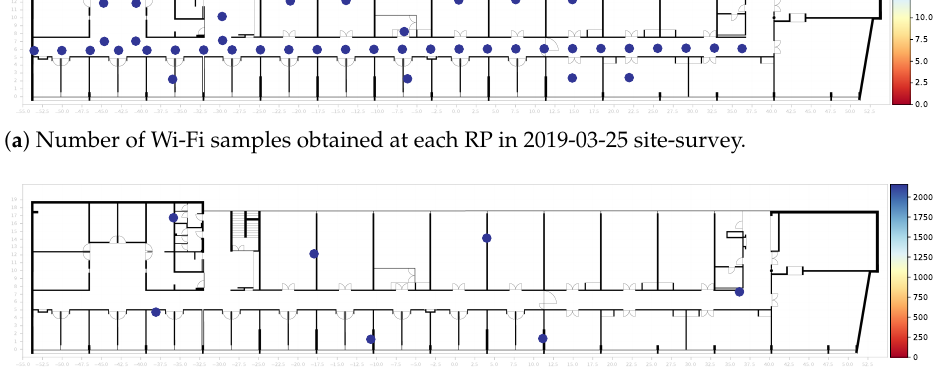
Figure 7. Number of Wi-Fi samples at each